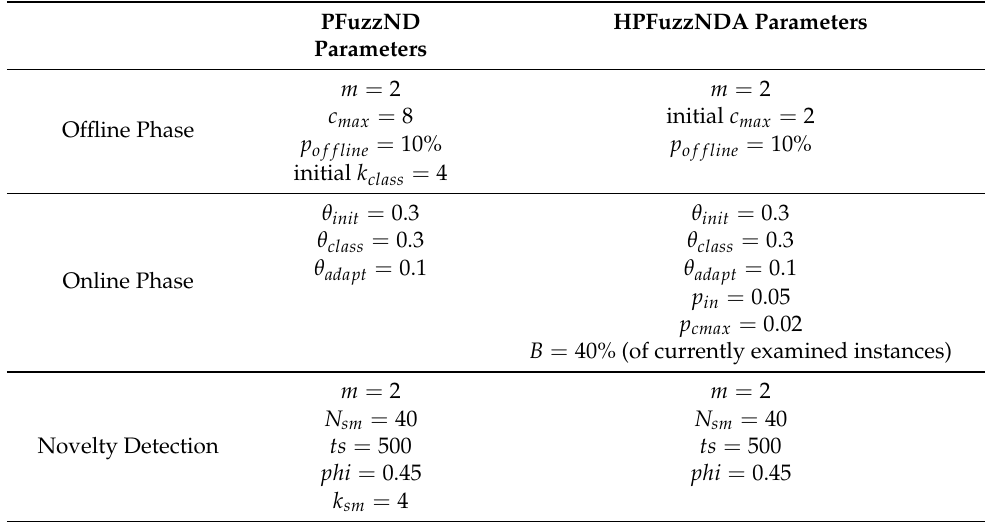
Table 4. Basic and newly introduced parameters of the PFuzzND and HPFuzzNDA